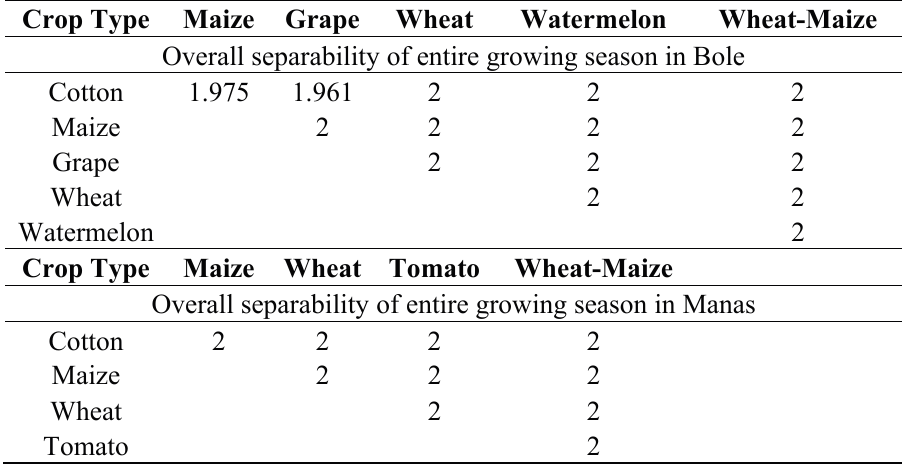
Table 4. Jeffries–Matusita (JM) distances for all pair-wise crop comparisons for the entire time series.